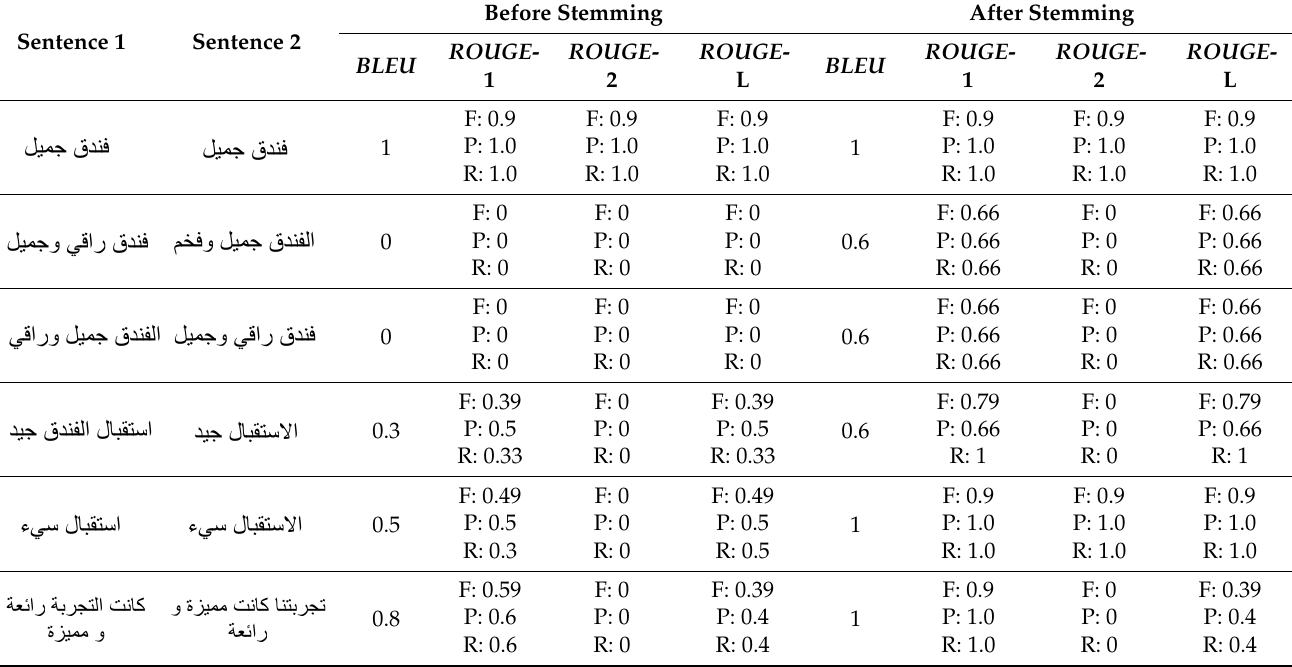
Table 6. Examples of BLEU and ROUGE scores of simple Arabic reviews illustrating the stemming effect.